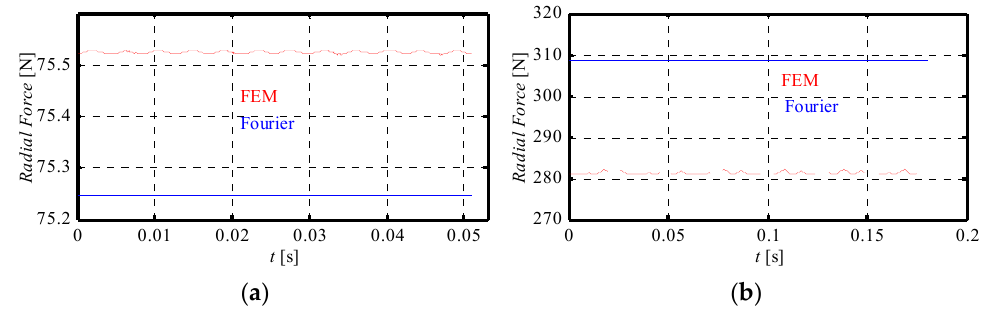
Figure 22. Forces created by the stator armature on the rotor surface: ( a ) Qs48p8, ( b ) Qs36p15.